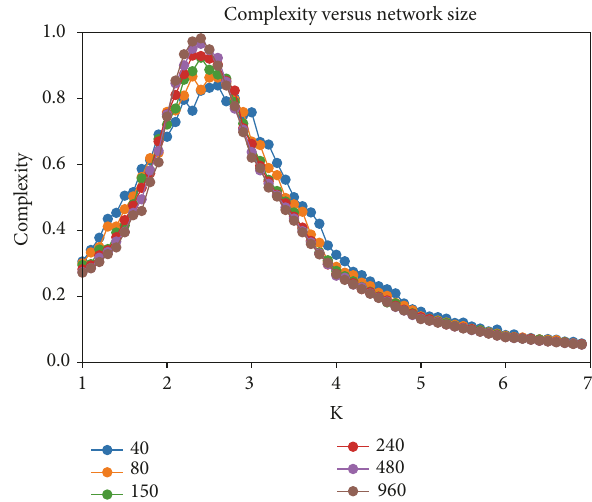
Figure 5: Complexity for different number of nodes, varying average connectivity K